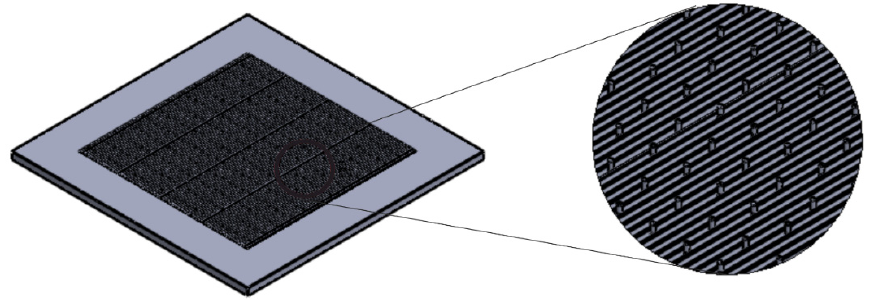
Figure 4. 3D model of the designed biomimetic leaf surface.